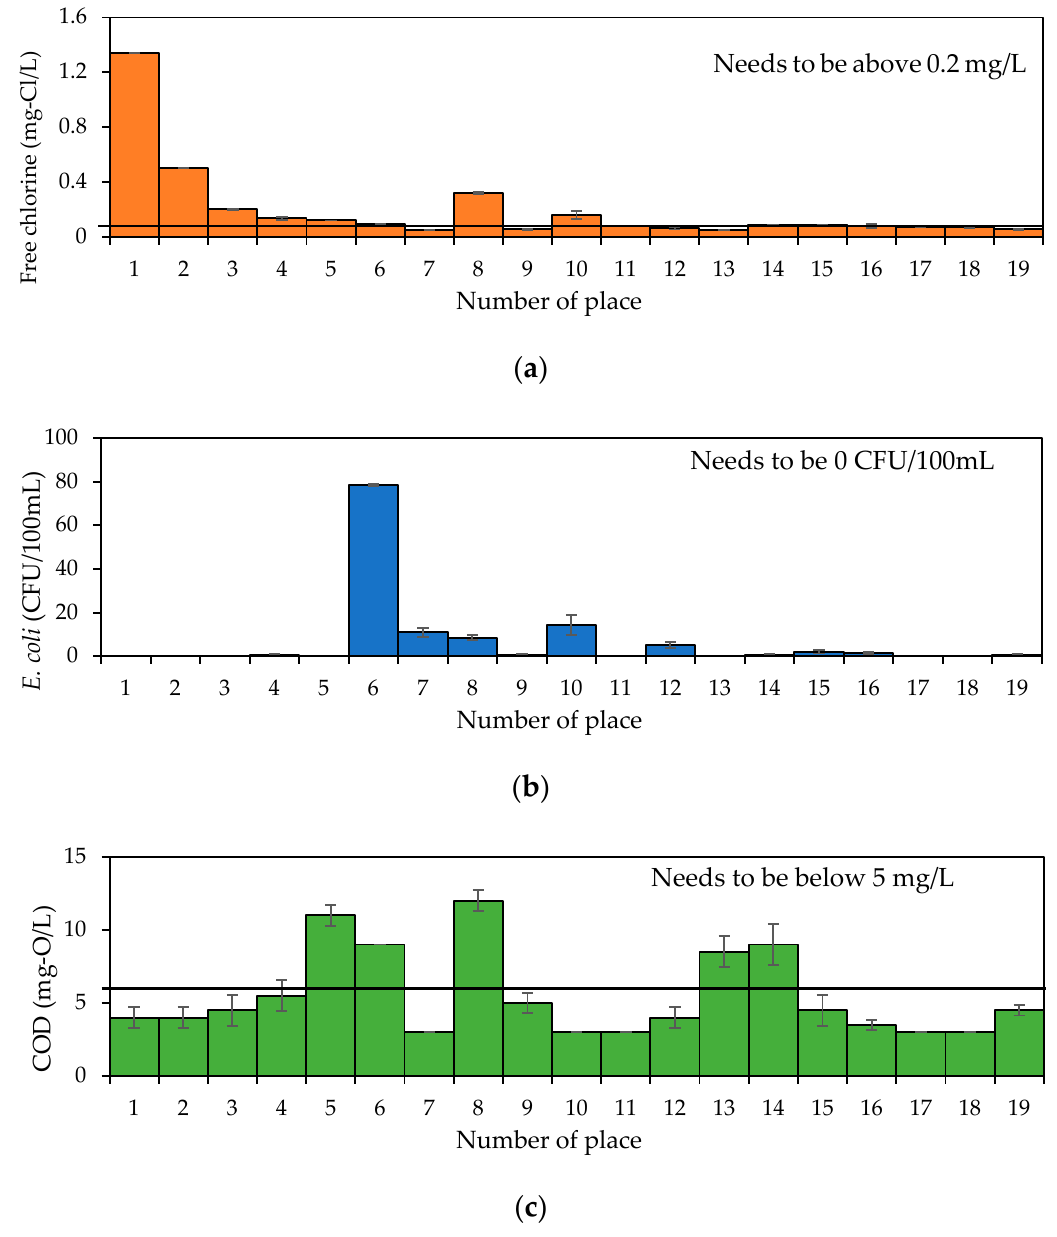
Figure 3. Free chlorine ( a ), E. coli ( b ) and COD ( c ) measurements from the Kampala water distribution system. The place numbers are as shown in Table 1 (n = 2). The error bars show the standard deviation of duplicate samples.